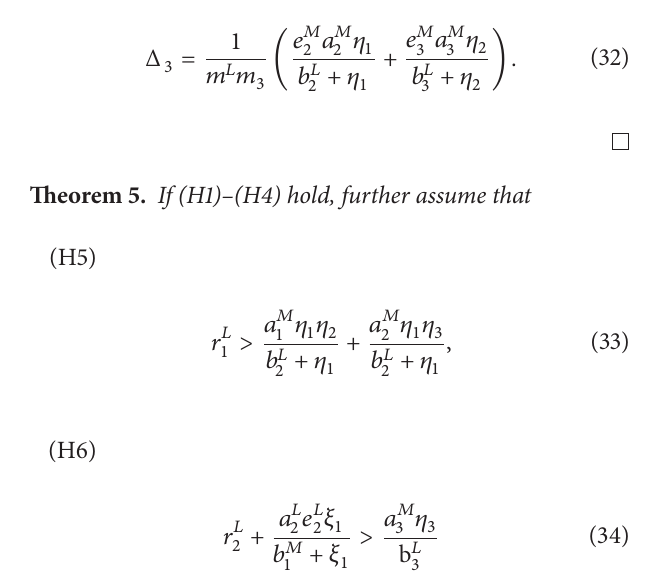
then, for any small positive 𝜀 2 > 0 , there exists 𝑇 2 > 0 , such that 𝑤 2 (𝑡) < Δ 2 + 𝜀 2 for 𝑡 > 𝑇 2